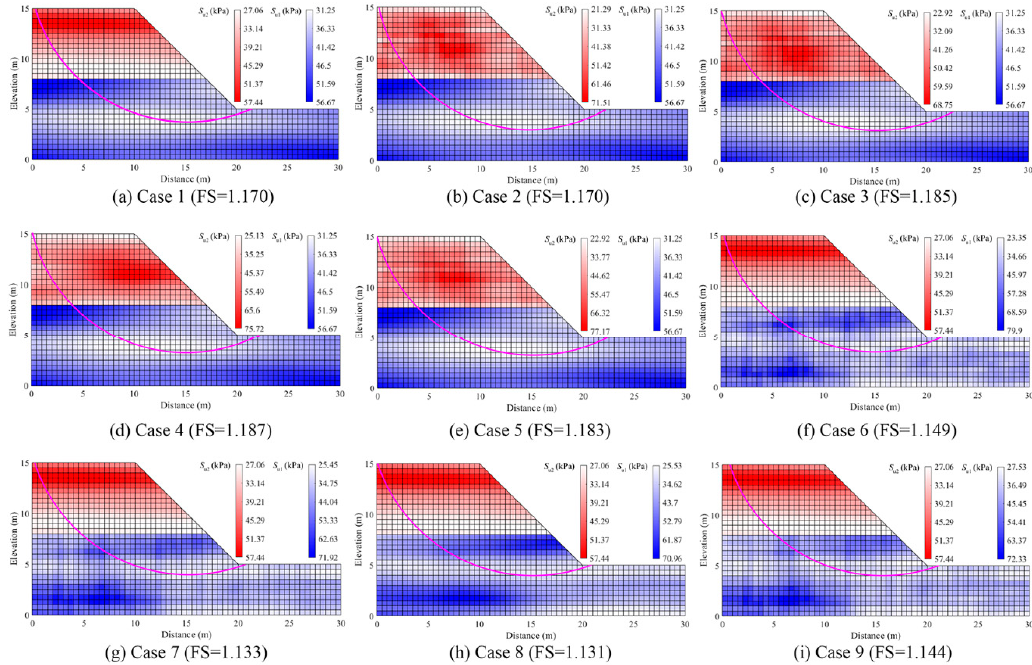
and S u associated slope stability results and (cid:1845) (cid:3048) associated slope stability 1 2 (cid:3117) (cid:3118)